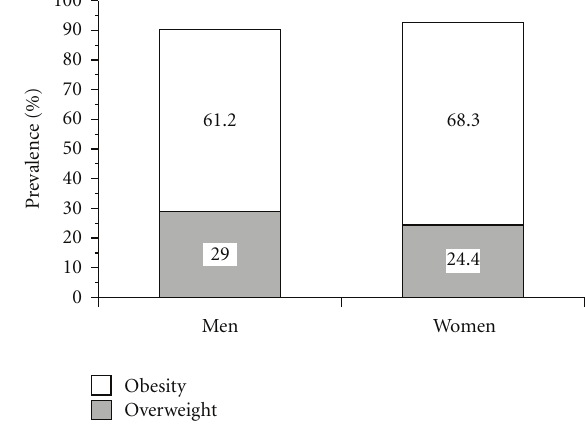
Figure 1: Prevalence of measured overweight (25kg/m 2 ≤ body mass index ≤ 29.9 kg/m 2 ) and obesity (body mass index ≥ 30 kg/m 2 ) among men and women from two remote First Nations communities of northwestern Ontario, Canada.